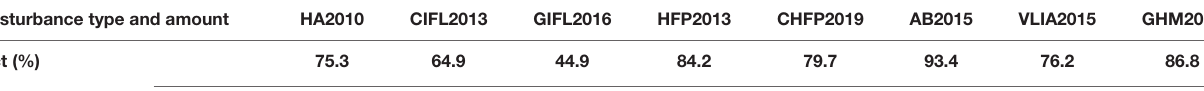
TABLE 5 | Percent length and area omitted (misclassified as intact) by each intactness and reclassified human influence map in the validation study area (boreal caribou